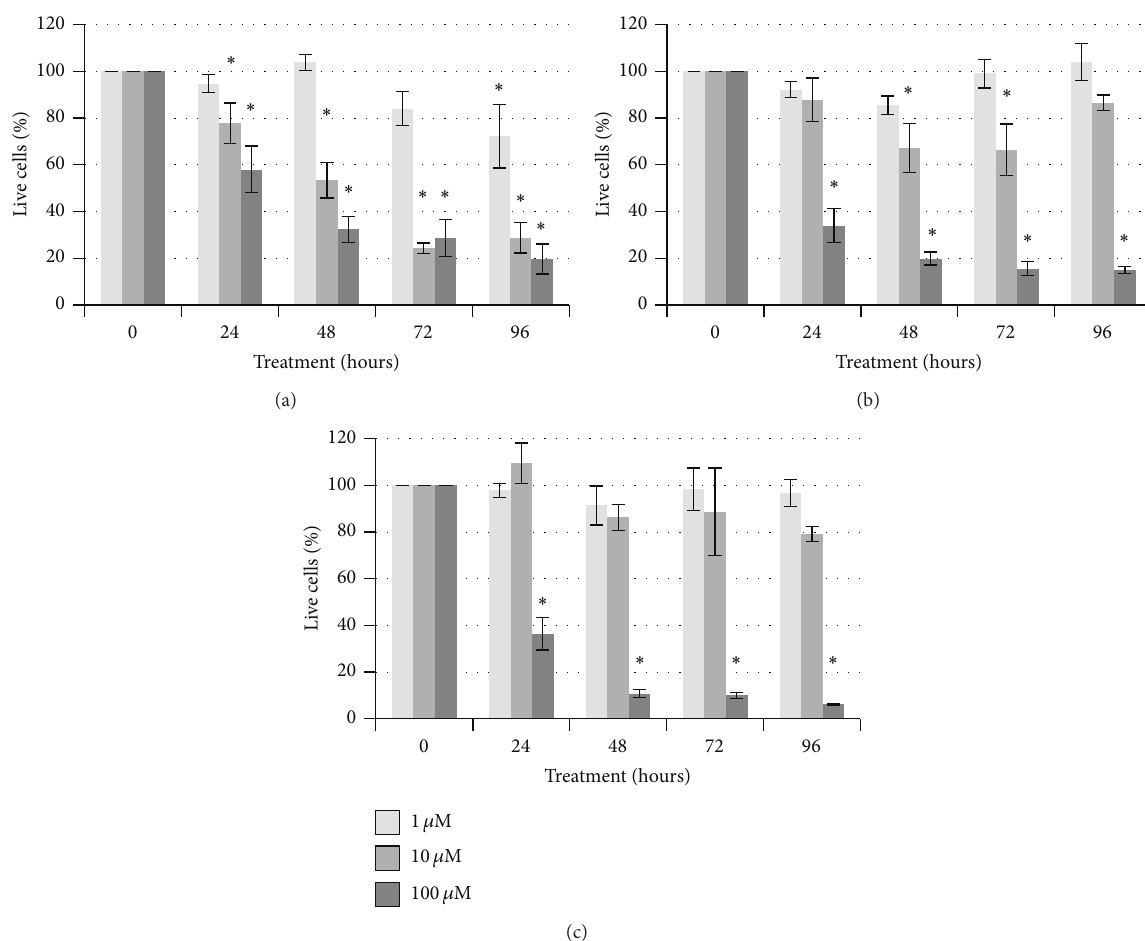
Figure 3: Viability of breast cancer cells after exposure to 1 𝜇 M, 10 𝜇 M, or 100 𝜇 M cantharidin. MDA-MB-231 (a), SK-BR-3 (b), or MCF-7 (c) cells were treated for up to 96 hours with cantharidin or DMSO vehicle control. Significant differences compared to the vehicle control ( ∗ 𝑃 < 0.05 ) are